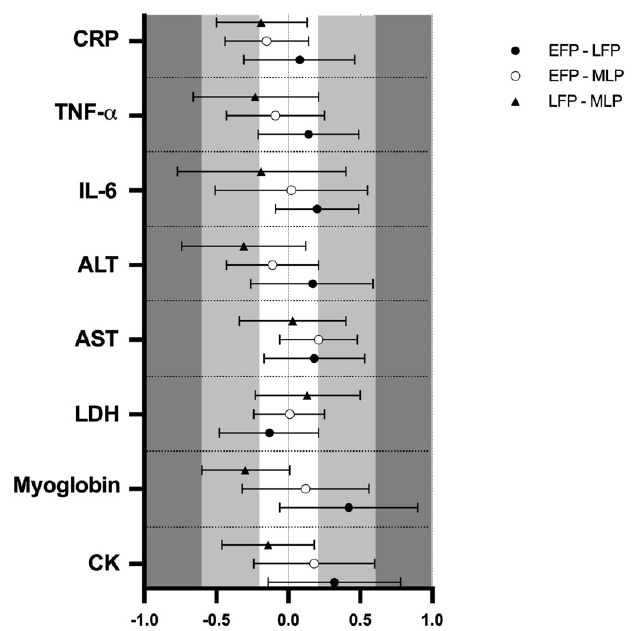
Figure 2. Standardized mean differences (ES) and confidence intervals in muscle damage and inflammation markers among menstrual cycle phases. EFP: early follicular phase, LFP: late follicular phase, MLP: mid-luteal phase. CK: creatine kinase, LDH: lactate dehydrogenase, AST: aspartate